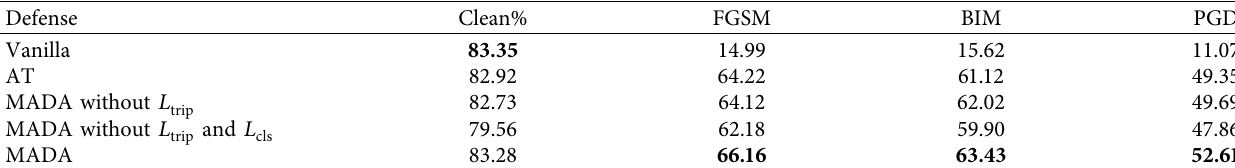
Table 5: Accuracy results on